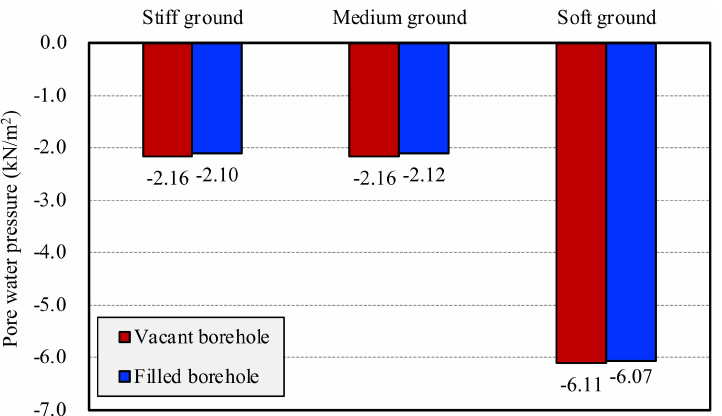
Figure 10. Comparison of porewater pressure for vacant and filled cases of double